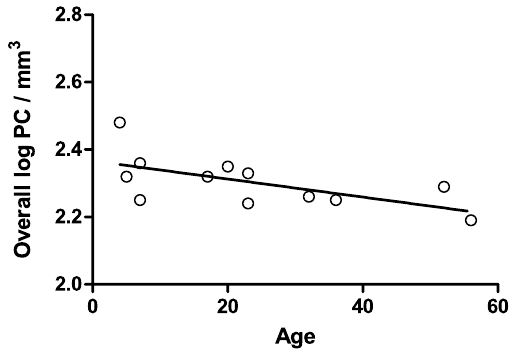
Figure 4. Overall PC Density Decreases with Age. Overall PC density obtained from the anterior, posterior, and flocculonodular lobes negatively correlates with age (R 2 = 2 0.39 6 0.14, p=0.030). Some cases were missing data from an individual region (as described in Methods) and were not included: one female and one male case from the autism and control groups were not